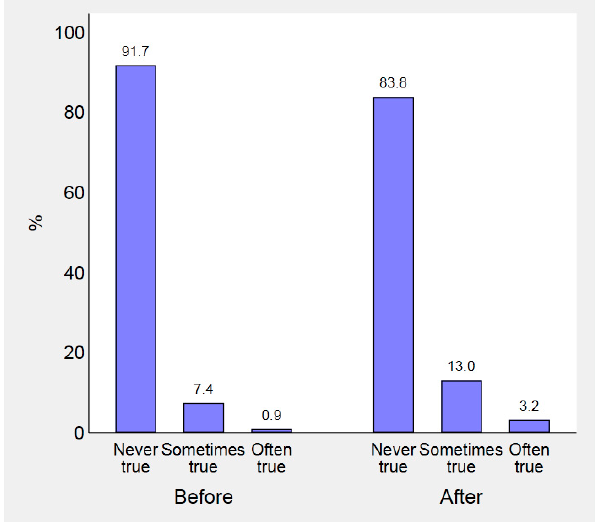
Figure 1. Frequency with which parents worried about running out of food, in the 12 months preceding and in the 6 months following COVID-19 outbreak.